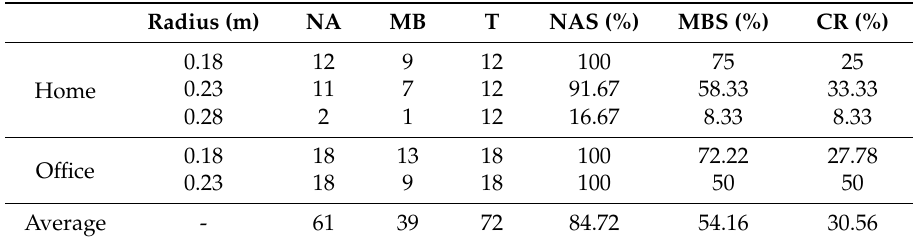
Table 5. Results of navigation success rate.